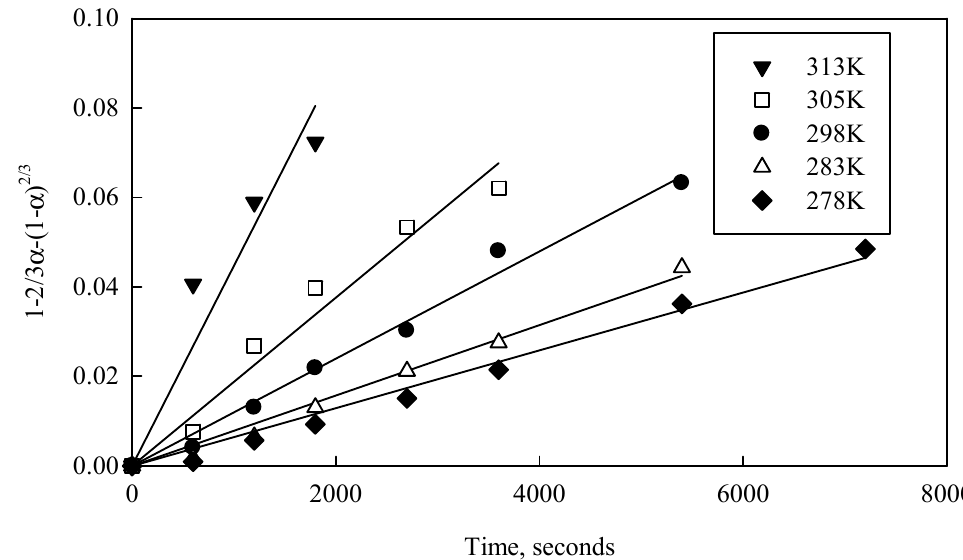
Figure 12. Analysis of malachite leaching kinetics as a function of temperature. The working conditions are the same as those in Figure 7. Table 1. Value of each apparent kinetics constant for the five temperatures studied.